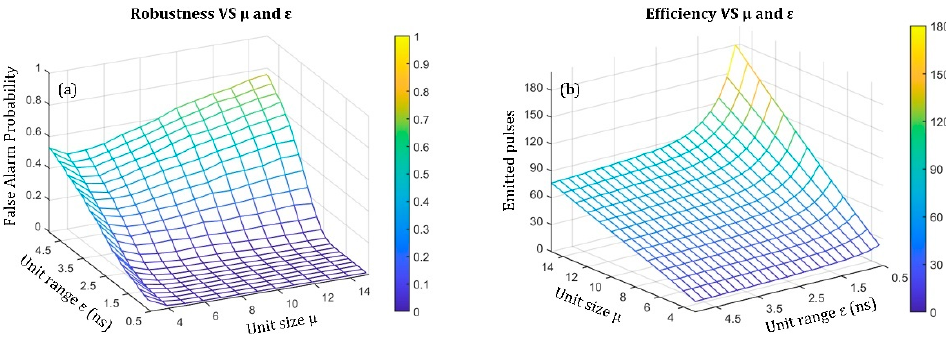
Figure 6. The relationship between µ - (cid:101) and efficiency-robustness. ( a ) Influence of µ - (cid:101) on robustness; ( b ) influence of µ - (cid:101) on noise efficiency.